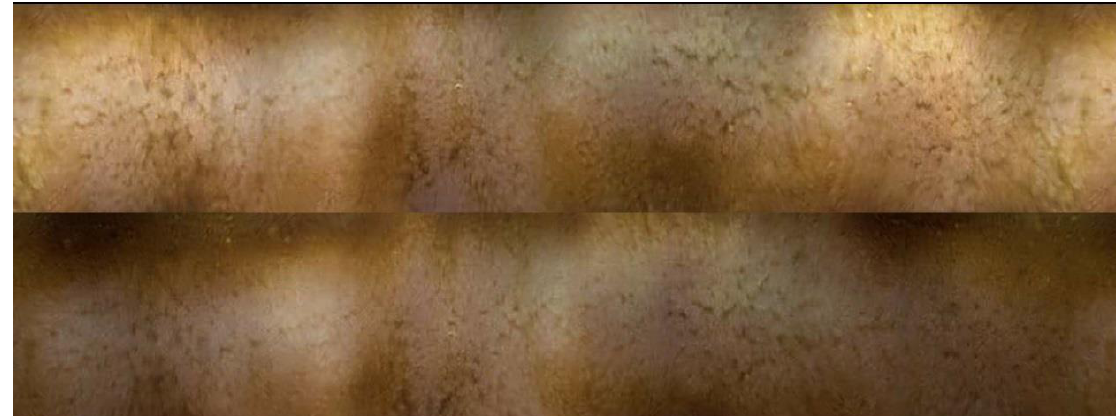
Figure 6. Wireless capsule enteroscopy. Normal ileum.